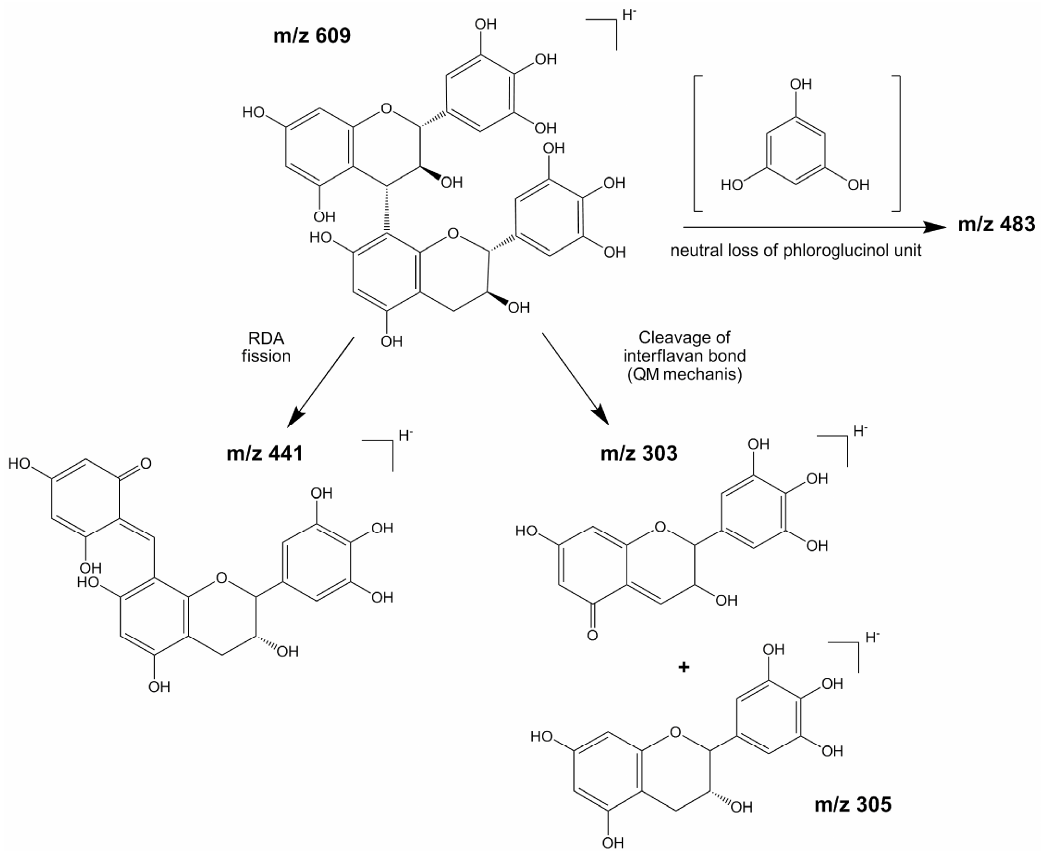
Figure 2. Hypothetical ESI( − )-MS/MS fragmentation pattern for Epigallocatechin dimer (peak 3, [M-H] − at m/z 609). RDA = Retro-Diels Alder fission, QM = Quinone Methide cleavage mechanism.